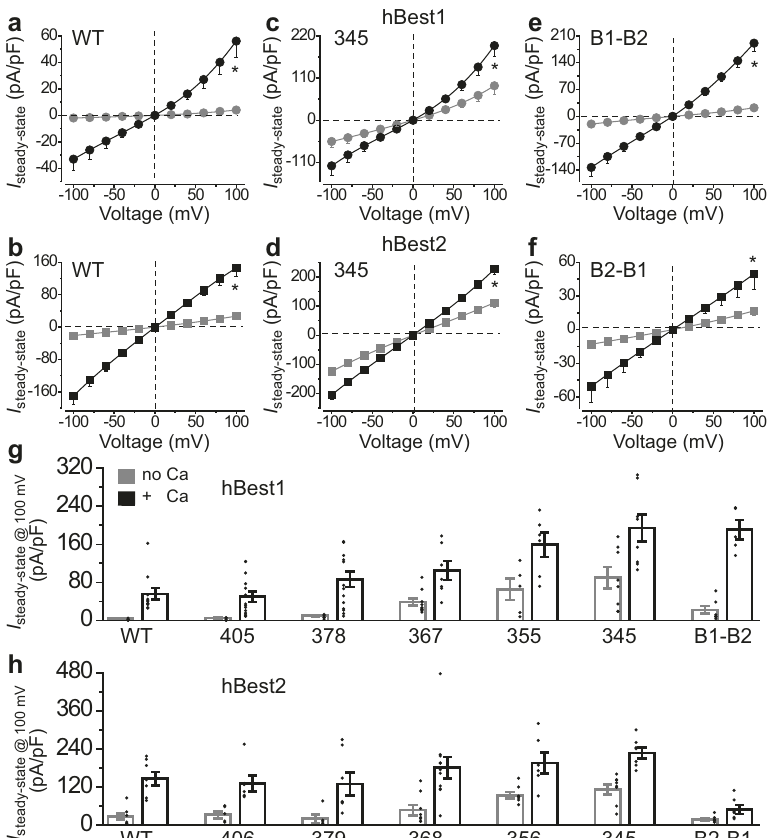
Fig. 5 Ca 2 + -dependent Cl − currents mediated by hBest1 and hBest2. a – f Population steady-state current density-voltage relationships in the absence (gray) and presence (black) of 1 μ M Ca 2 + from HEK293 cells expressing WT hBest1 a , WT hBest2 b , hBest1 1 – 345 c , hBest2 1 – 345 d , hBest1 1 – 345 -hBest2 346 – 406 e , or hBest2 1 – 345 -hBest1 346 – 405 f ; n = 5 – 11 biologically independent cells for each point. * P < 0.05 compared to currents without Ca 2 + , using two-tailed unpaired Student t test. g , h Bar chart showing the steady-state current densities from HEK293 cells expressing the indicated hBest1 g or hBest2 h channels in the absence and presence of 1 μ M Ca 2 + , n = 5 – 15 biologically independent cells for each bar. B1-B2: hBest1 1 – 345 -hBest2 346 – 406 , B2-B1: hBest2 1 – 345 - hBest1 346 – 405 . Data are presented as mean values ± SEM. Source data and the precise n and P values are provided in the Source Data fi